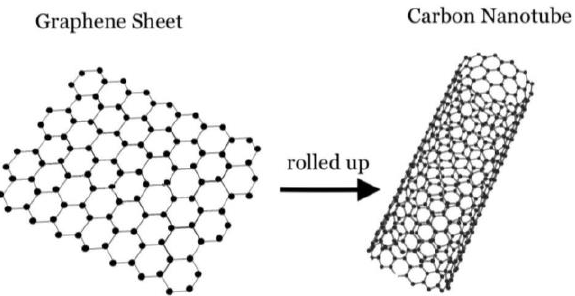
Figure 2. Graphene sheet rolled up to form a single-walled CNT [40].